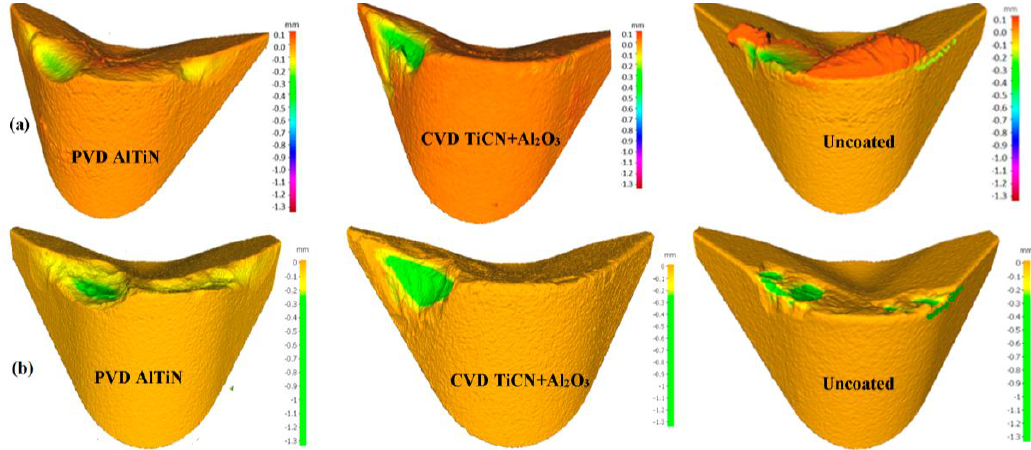
Figure 5. Alicona 3D images of the cutting tools after machining of SDSS ( a ) before, and ( b ) after etching showing the details of the cutting tools with their major wear mechanisms.